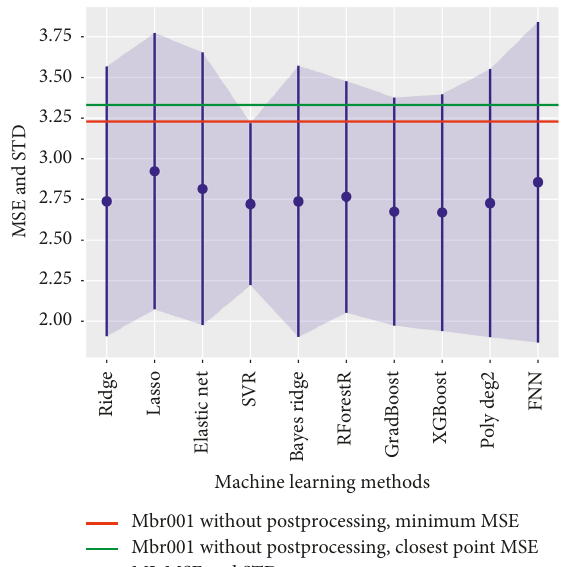
Figure 16:10meters total wind calibration plot for M´alaga airport. Horizontal axis as in Figure 12.